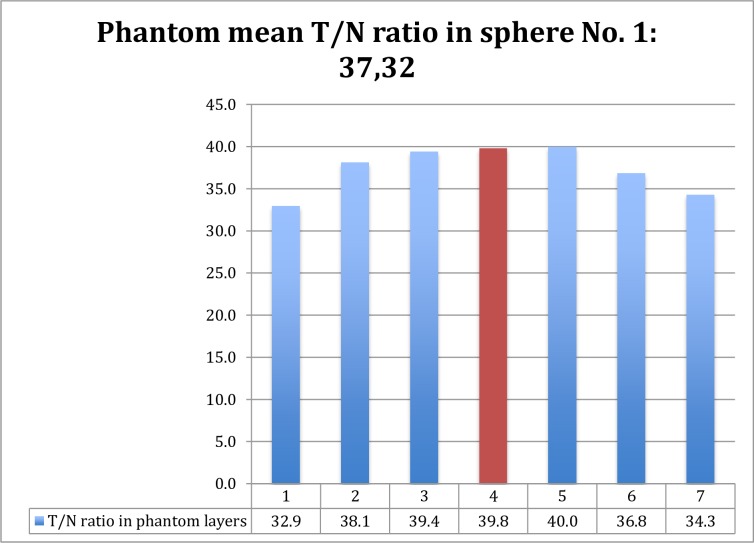
“Tumor-to-normal-tissue-ratio in the phantom: phT/N” in particular layers of sphere No.1 of IEC-phantom.There is no significant difference between T/N ratio of median layer (red) and mean phantom total T/N ratio of sphere No. 1. (p = 0.148, Student t-test).